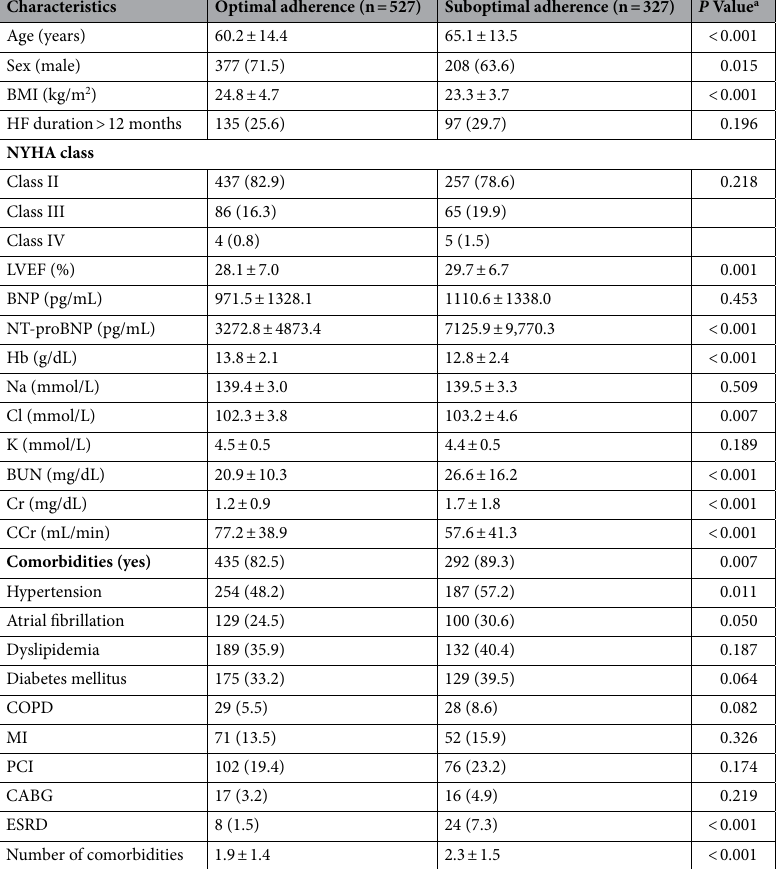
Table 1. Baseline characteristics of patients with optimal adherence and suboptimal adherence at enrollment. Data are presented as number (%) or mean ± standard deviation. BMI, body mass index; BNP, B-type natriuretic peptide; BUN, blood urea nitrogen; CABG, coronary artery bypass grafting; CCr, creatinine clearance; Cl, chlorine; COPD, chronic obstructive pulmonary disease; Cr, creatinine; ESRD, end-stage renal disease; Hb, hemoglobin; HF, heart failure; K, potassium; LVEF, left ventricular ejection fraction; MI, myocardial infarction; Na, sodium; NT-proBNP, N-terminal pro B-type natriuretic peptide; NYHA, New York Heart Association; PCI, percutaneous coronary intervention. a P values were calculated using the Student’s independent 2-sample t -test or χ 2 test as